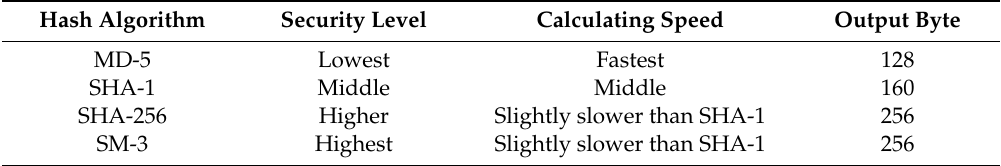
Table 1. The performance comparison of the typical hash algorithms.